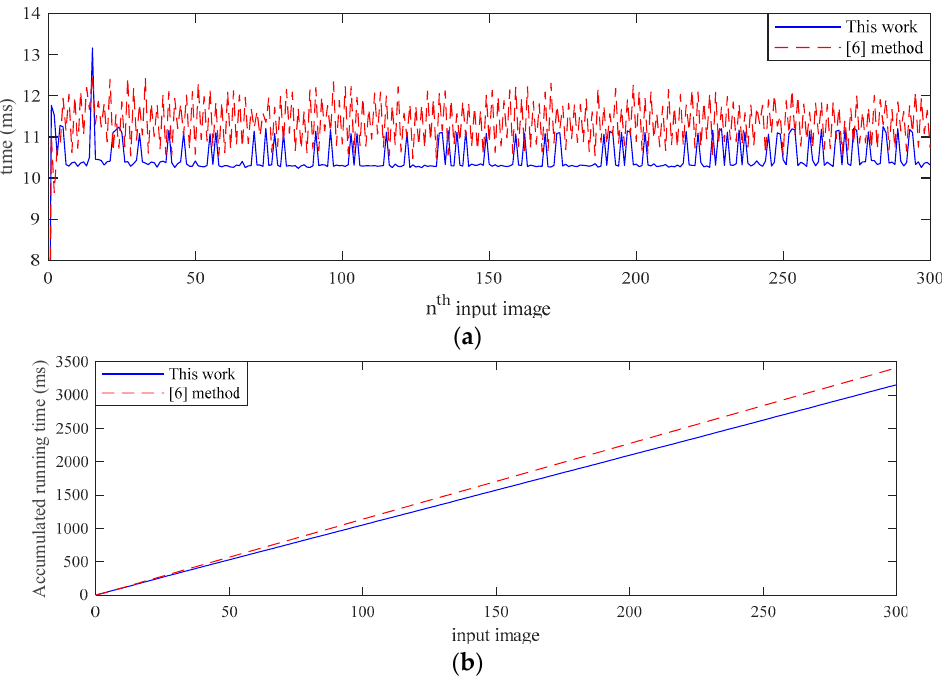
Figure 7. ( a ) Comparison of the processing time in lane detection for a series of 300 images and ( b ) the accumulated computation time validates that the algorithm in this work is more efficient.